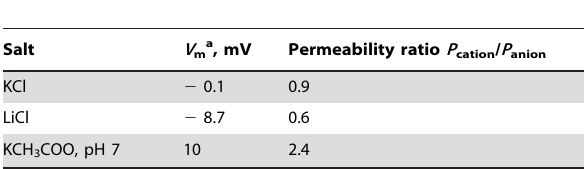
Table 4. Zero-current membrane potential, V m of diphytanoylphoshatidylcholine/ n -decane membranes in the presence of BesC measured for a 10-fold gradient of different